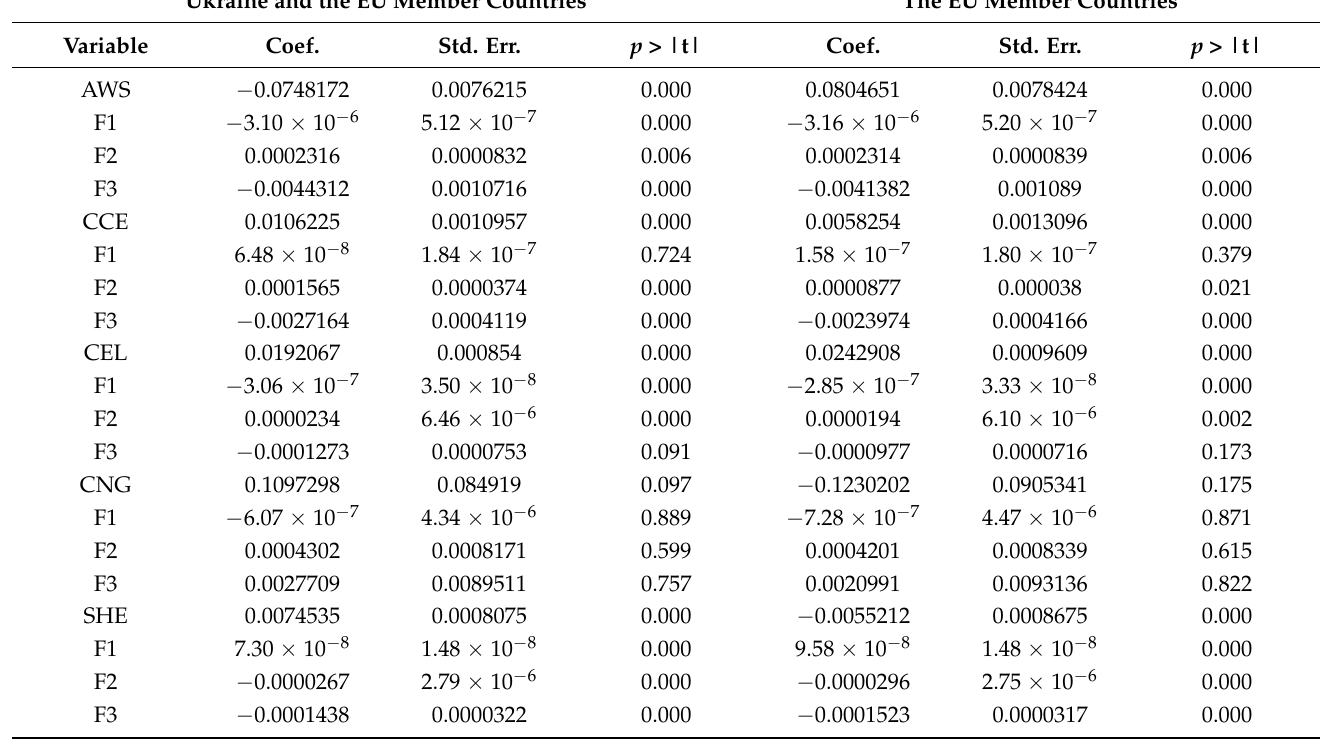
Table 3. The results of the calculation assessing β -convergence of energy efficiency indicators in the economic